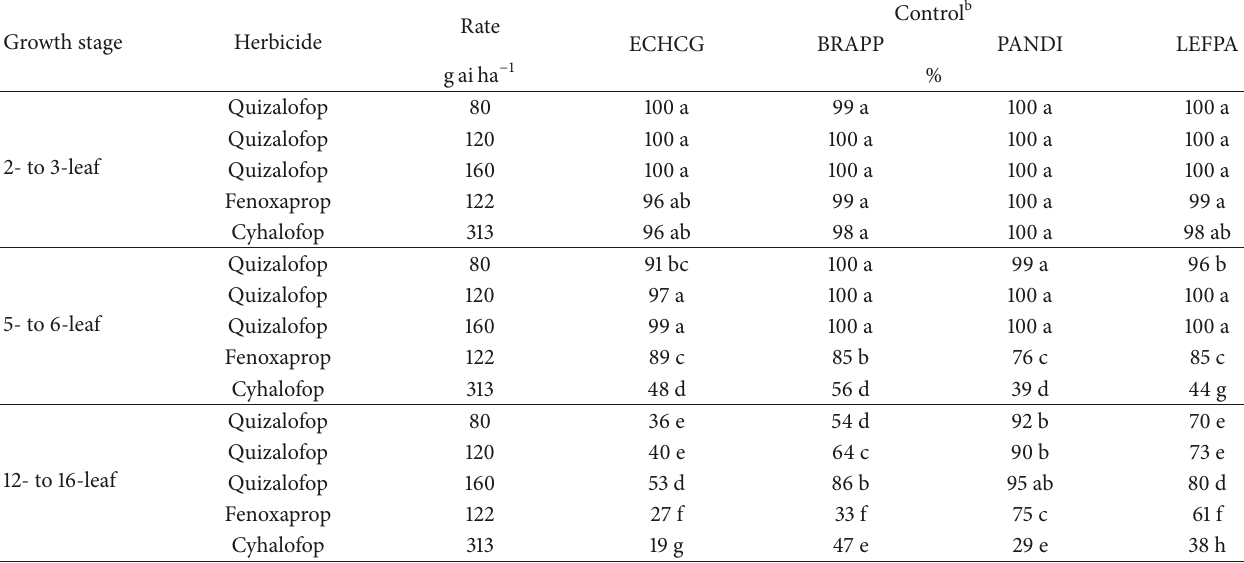
Table 1: Effect of ACCase-inhibiting herbicide and growth stage at time of application for control of barnyardgrass, broadleaf signalgrass, fall panicum, and Amazon sprangletop at 21 DAT. a Rate Growth stage Herbicide